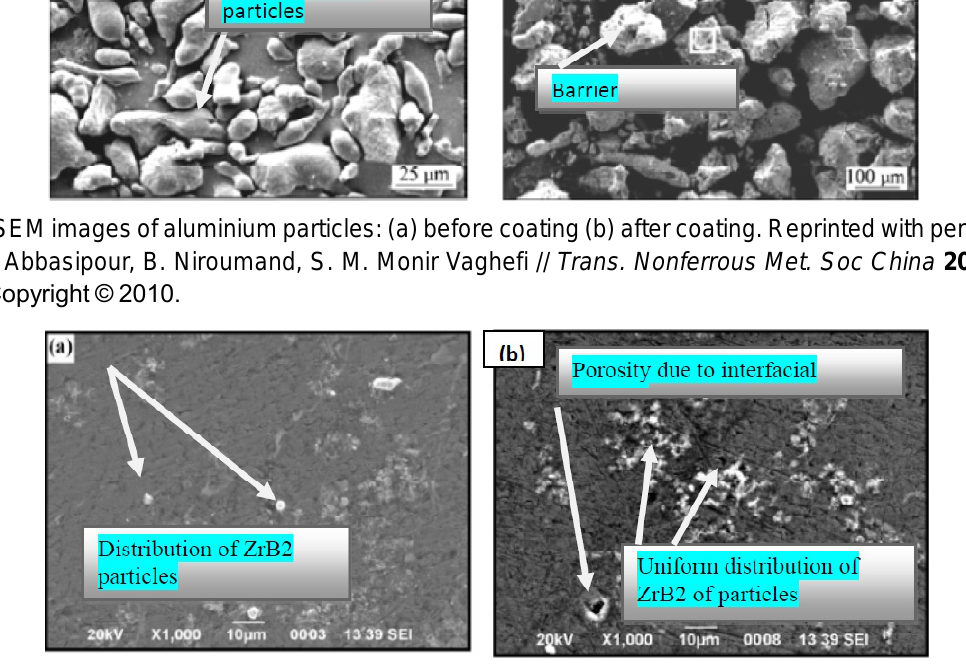
and 10% ZrB . Reprinted with permission from I. 2 2